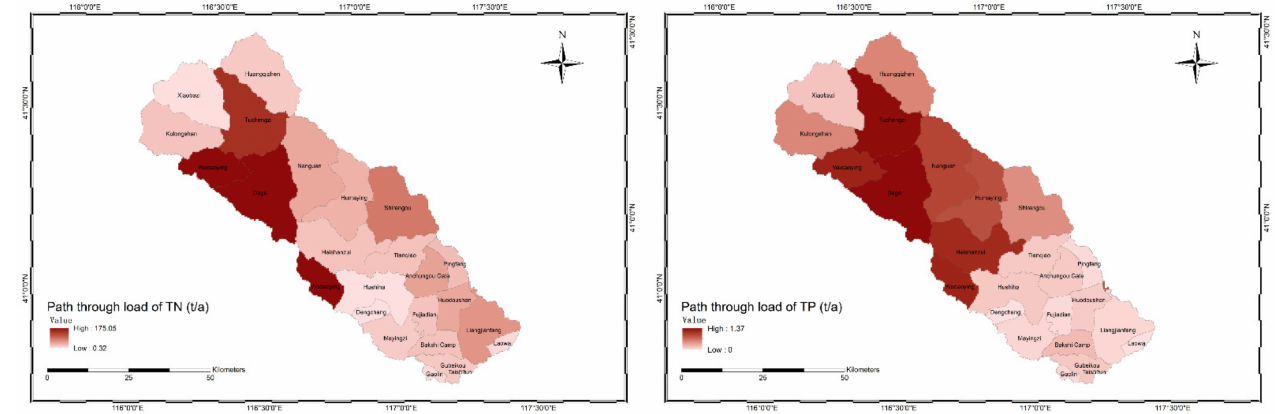
Figure 6. Spatial distribution characteristics of the path-through rate load of NPS